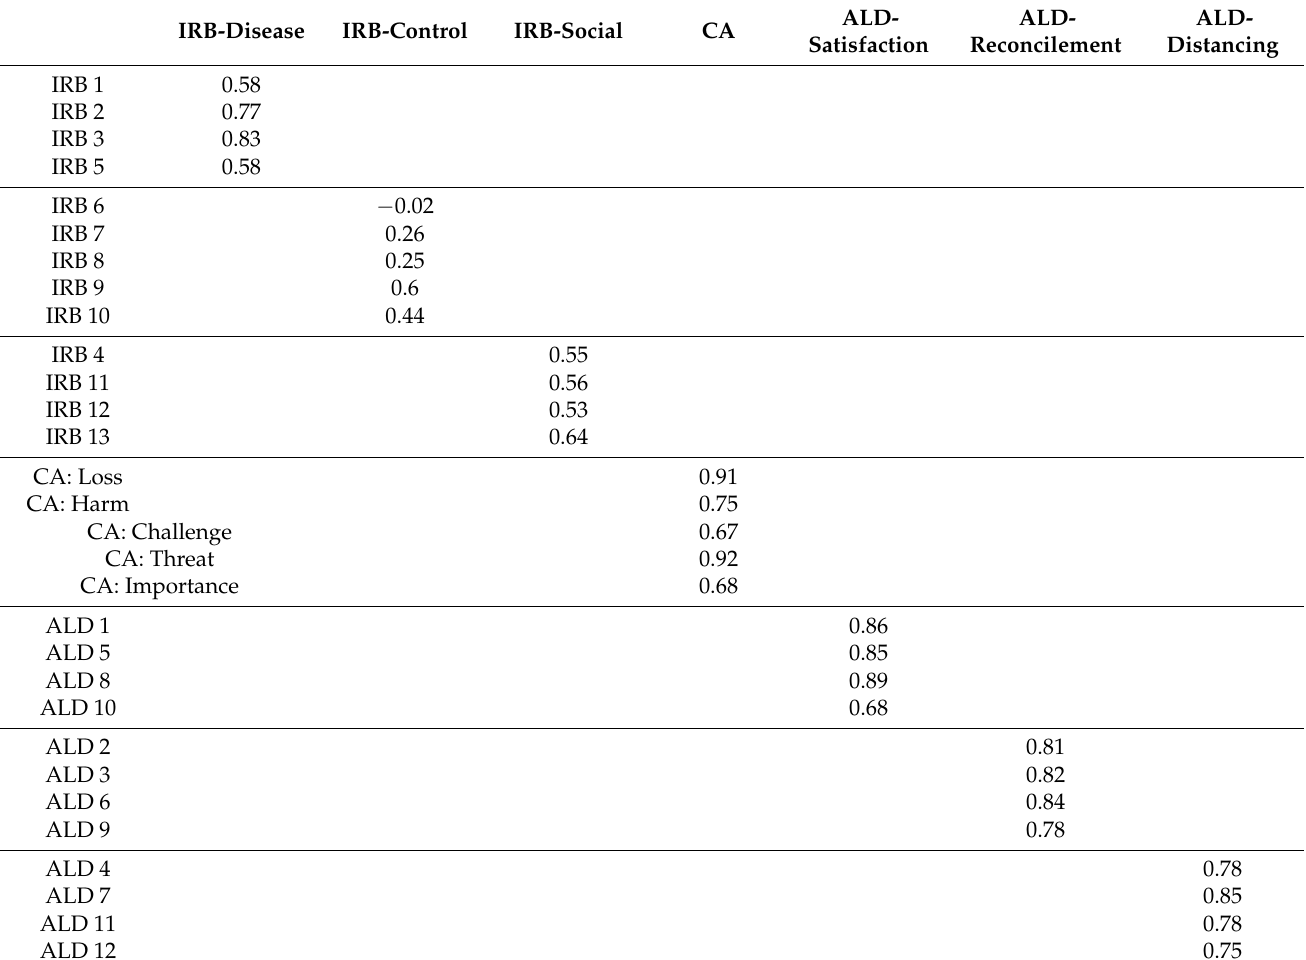
Table 2. Standardized factor loadings for all latent variables.